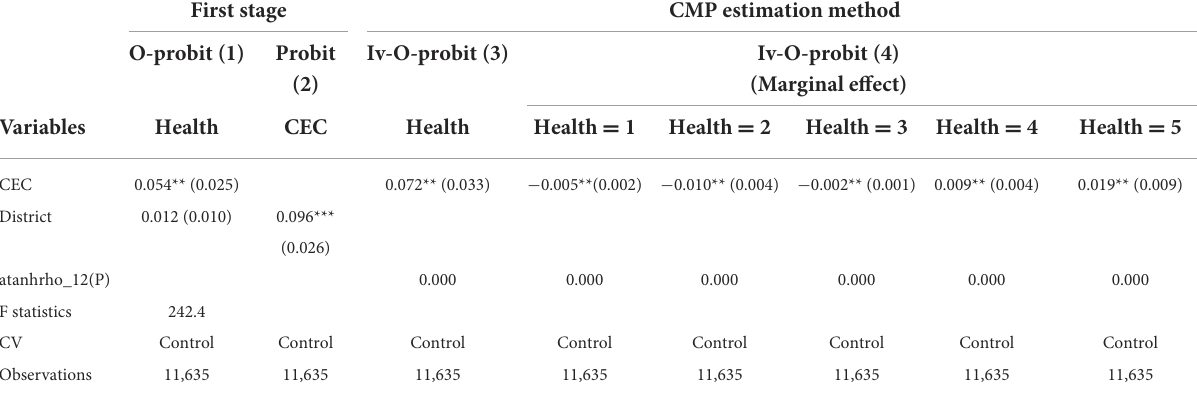
TABLE 5 The results of endogenous treatment of CEC and health with CMP estimation method.